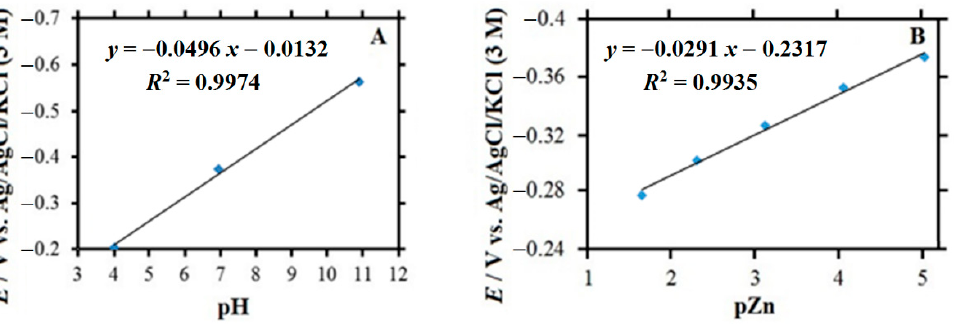
Figure 5. Calibration curves of the microelectrodes sensitive to pH and Zn 2+ ions in the double-barrel assembly. ( A ) Linear pH response for the antimony microelectrode for 4 ≤ pH ≤ 11; ( B ) linear behavior of the Zn-ISME for 1.5 ≤ pZn ≤ 5.